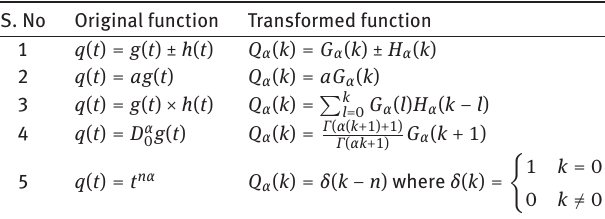
Table 1: Fundamental properties of the DTM S. No Original